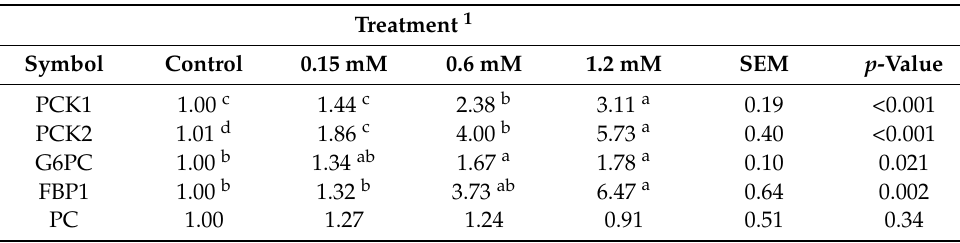
Table 2. The expression of genes involved in the gluconeogenesis pathway in bovine hepatocytes incubated with 0 (control), 0.15, 0.6, and 1.2 mM His in vitro. ( n = 6).